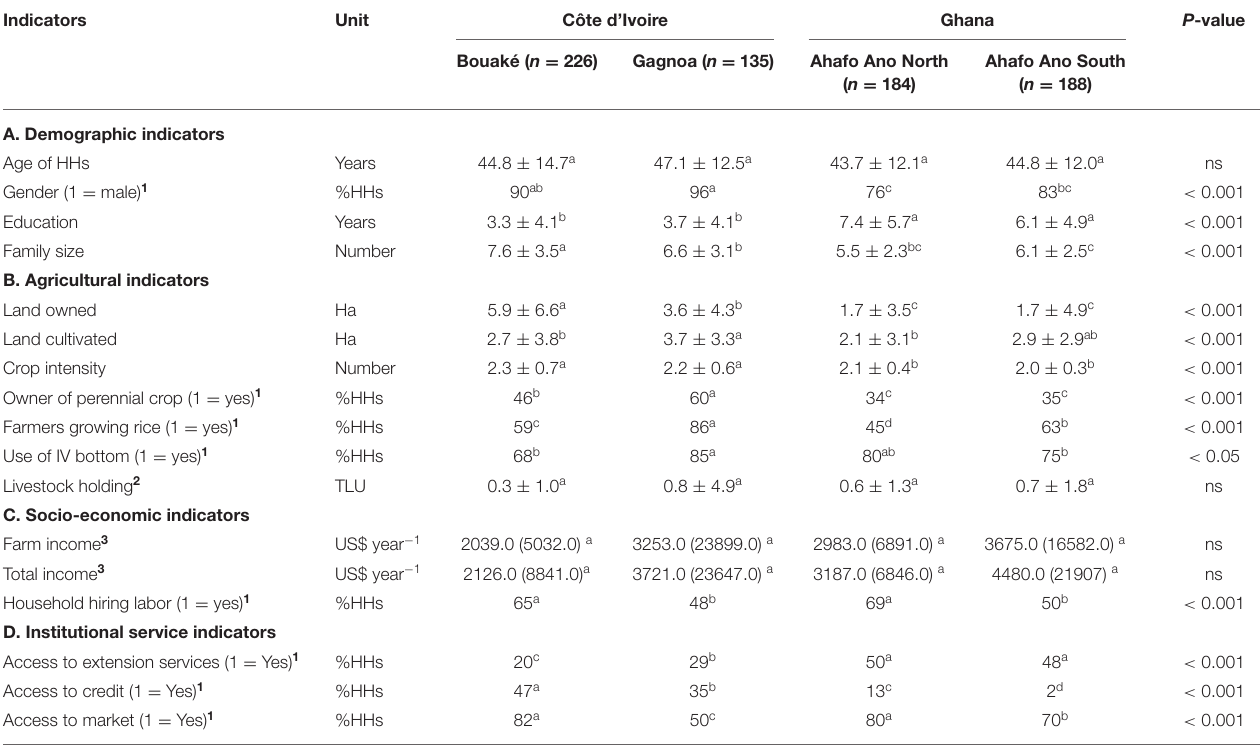
TABLE 3 | Farm household characteristics in the four study regions based on the household baseline survey 2018–2019; (proportion or means ± standard deviation). Indicators